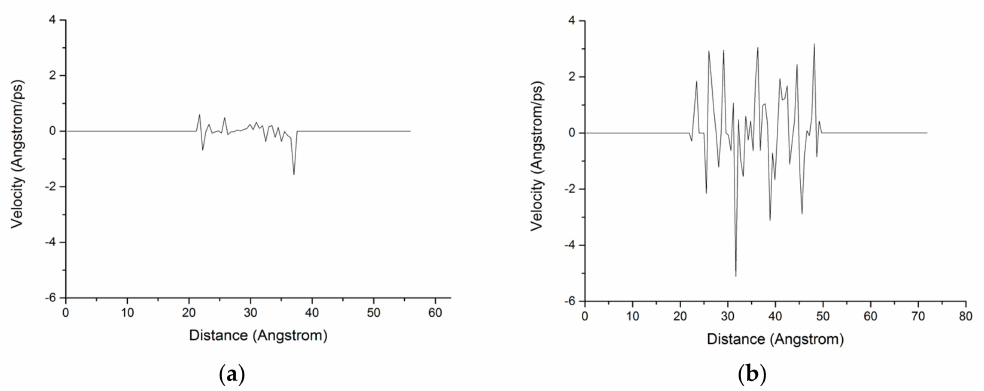
Figure 9. Distribution of the chloride ion di ff usion rate in the C-S-H pore structure with a pore diameter of 1.5 nm. ( a ) Without fatigue loading; ( b ) Under fatigue